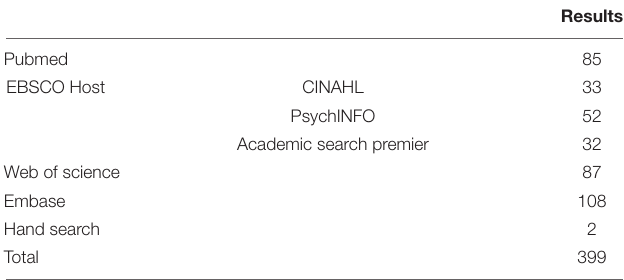
TABLE 1 | Results per database.